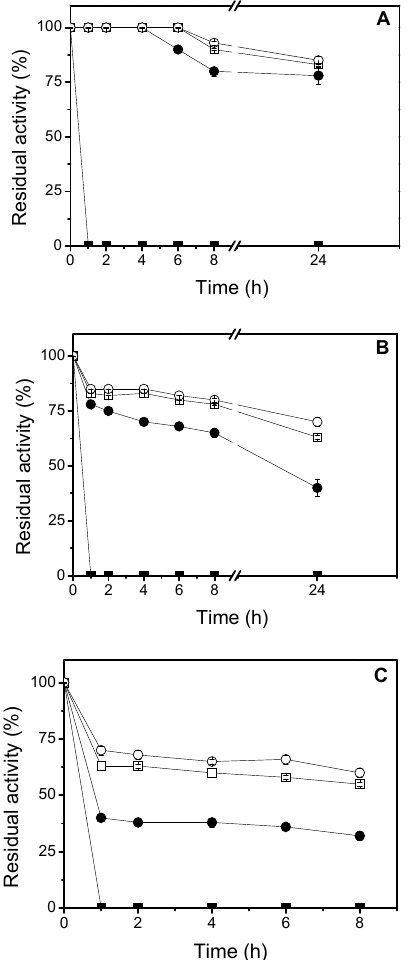
Figure 2. Thermal stability of lipases adsorbed on covalent supports. ( A ) 50 °C; ( B ) 60 °C; ( C ) 70 °C. Symbols: ■ CNBr derivative; ● GA-crosslink derivative; □ GX derivative; ○ GA derivative.